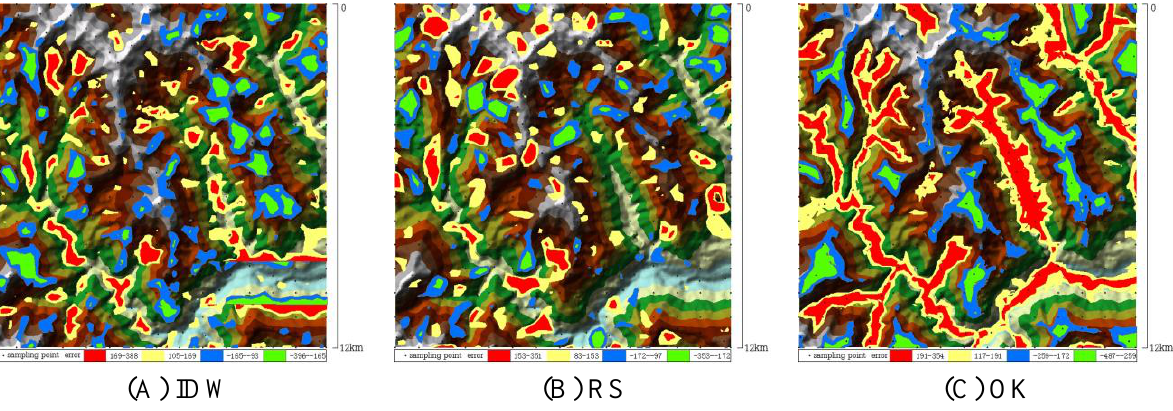
Figure 5. The distributions of errors in combined sampling. ( A ) Error distributions of IDW; ( B ) Error distributions of IDW; ( C ) Error distributions of